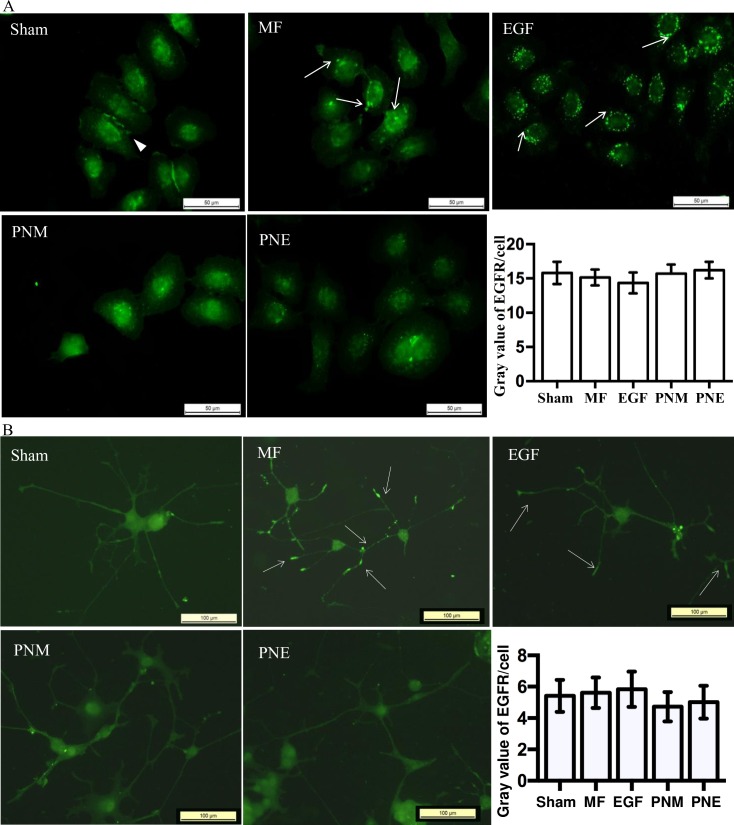
MF induced clustering and redistribution of EGFR.EGFR was labeled in green fluorescence in FL cells (A), and PC12 cells (B). The groups were treated as described in Fig 1 and in Materials and Methods. The horizontal bar represents 50 μm in A, and 100 μm in B, respectively. The average gray value /content of EGFR per cell was quantified in the bar chart, and more than 50 cells were measured for each group (see details in S1 Table), p-value > 0.05 when compared to the Sham by Student’s t-test. For all experiments, the repeat times were seen in the S1 Table.